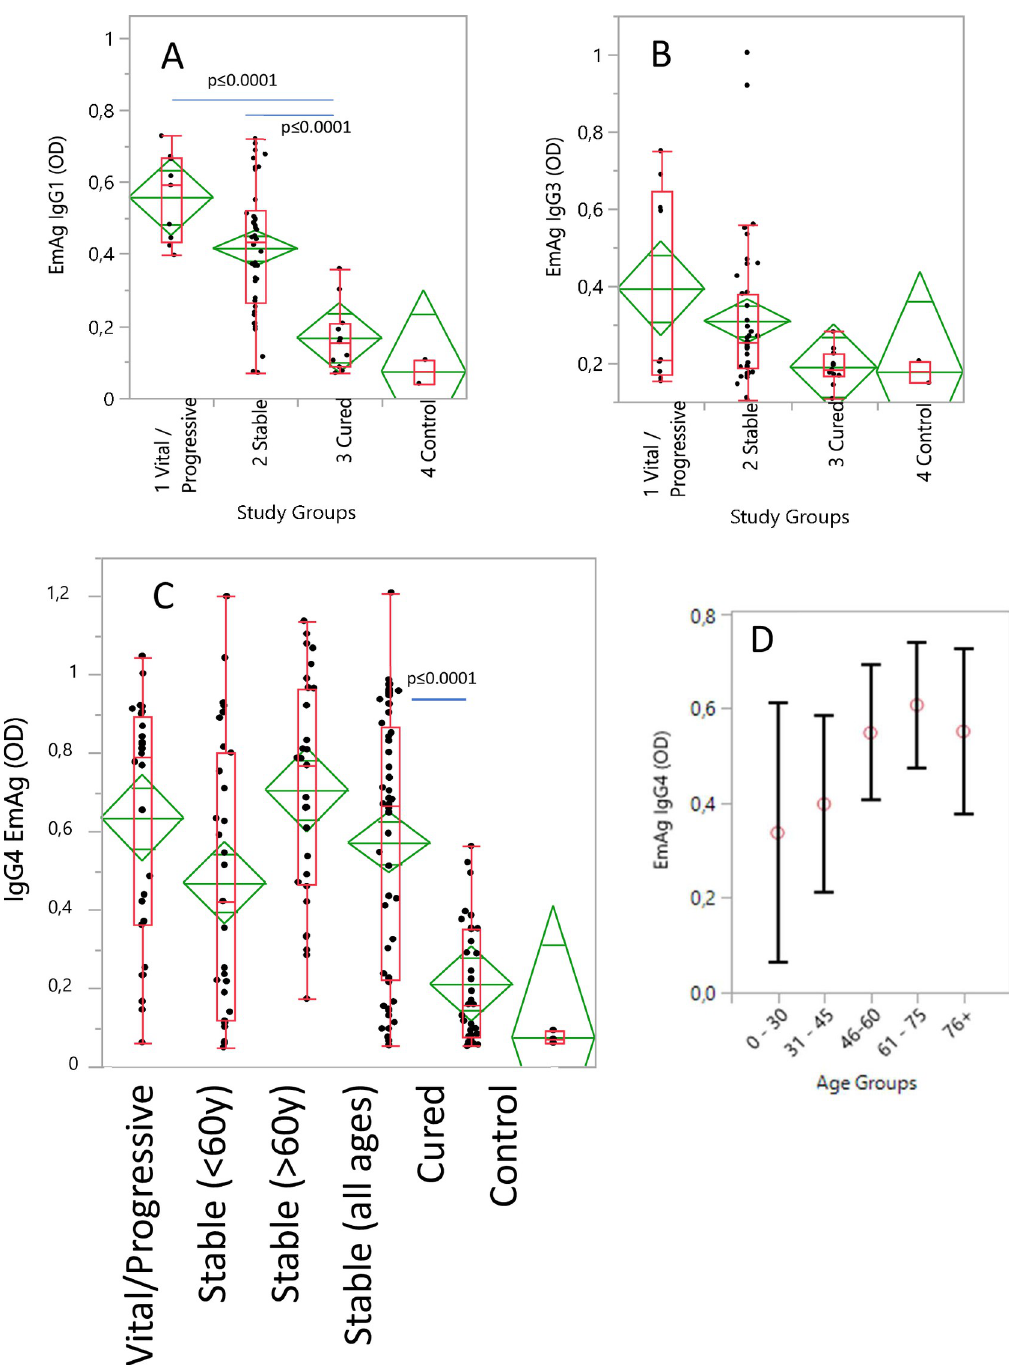
Fig 1. The E. multilocularis antigen-specific IgG reactivity (OD) in alveolar echinococcosis (AE) patients and infection- free controls. The AE patients were staged into those with progressive AE, with stable ( < 60y), stable ( � 60) and cured AE. For the determination of age dependent EmAg specific IgG4 responses, the patients were grouped in five age groups. Blood samples from AE patients were collected at three time points in 2005 (year 1) in 2010 (year 5) and in 2016 (year10). Controls were echinococcosis infection-free healthy blood donors. In (A) the EmAg specific IgG1, in (B) the EmAg specific IgG3 and in (C) the EmAg specific IgG4 responses are shown as mean optical densities (OD) with the 95% confidence intervals for the means (diamonds). The data presented in box plots show the median OD per group with the 25% and 75% quartiles and the 1,5x of the interquartile range with outlier as individual points. In (D) the IgG4 reactivity in AE patients to EmAg is shown as mean OD per age group with the 95% confidence